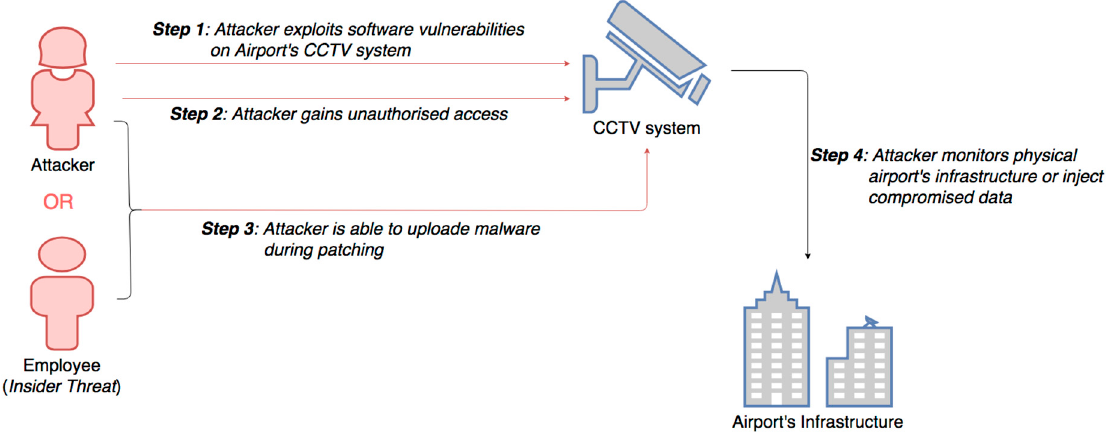
Figure 11. Network attack on CCTV systems.